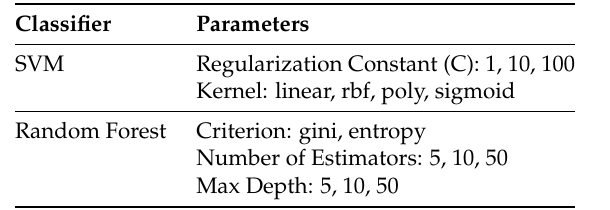
Table 2. SVM and random forest training configurations.